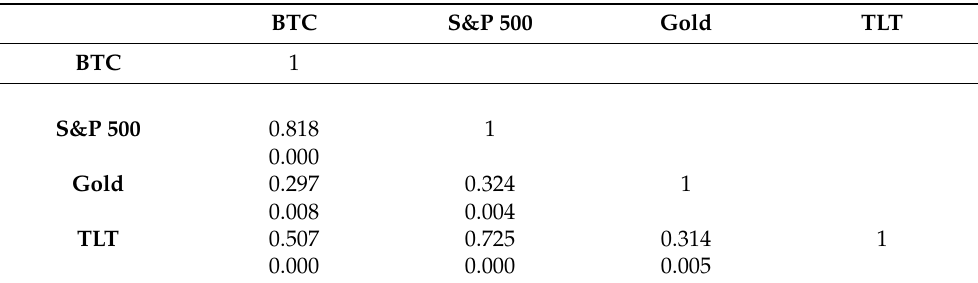
Table 5. Pearson correlation coefficient between Bitcoin, S&P 500, Gold and